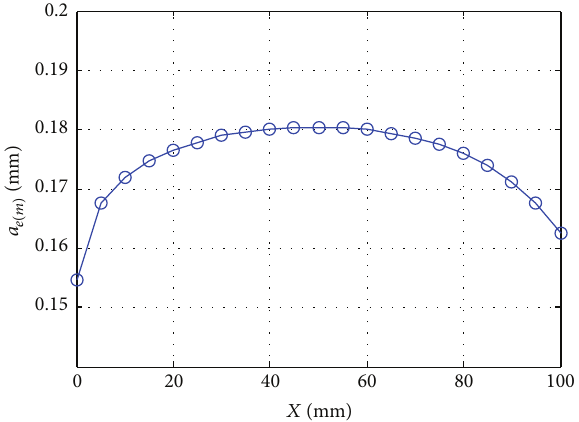
Figure 8: Change of actual radial depth at different tool positions.